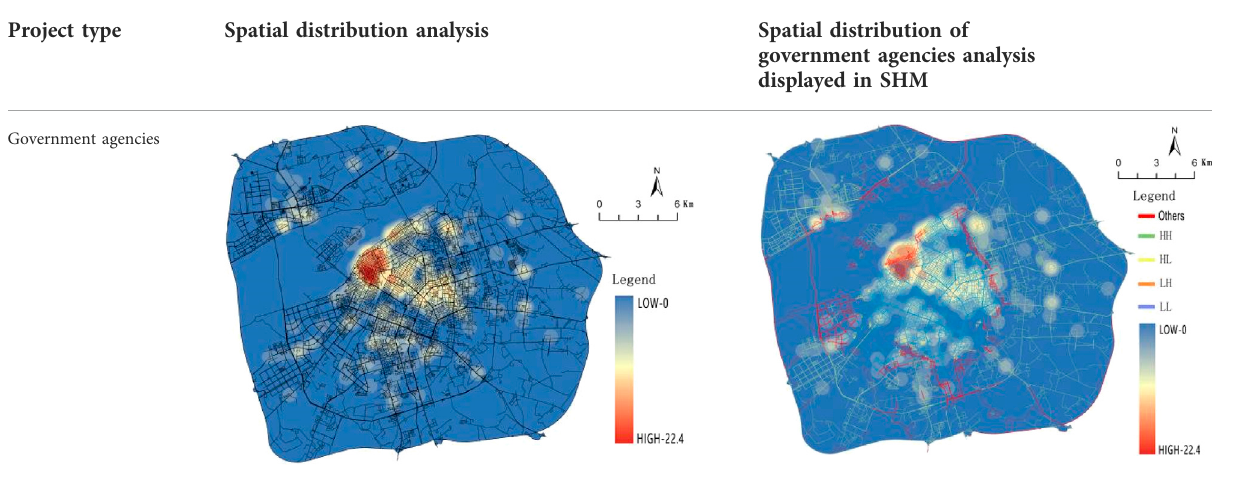
TABLE 3 Spatial distribution of single infrastructure (Government agencies) in SHM.